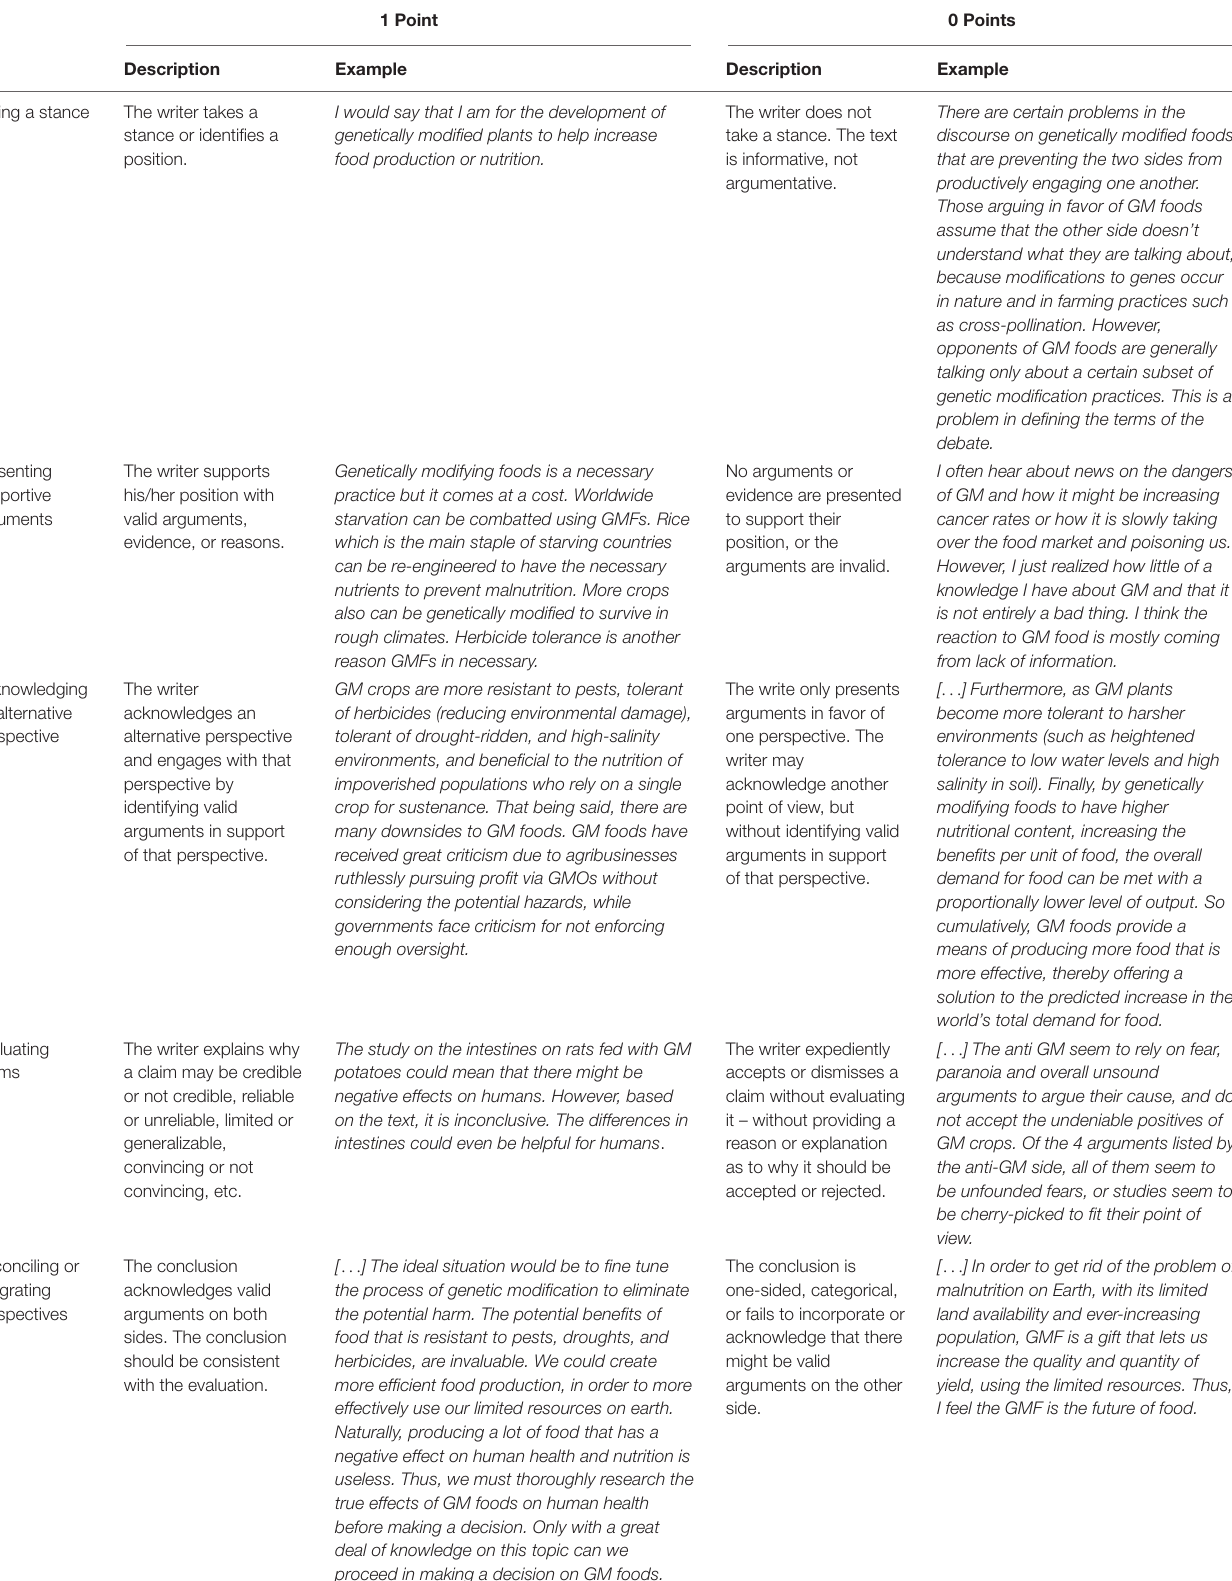
TABLE 2 | Coding scheme for critical thinking in argumentative essays.